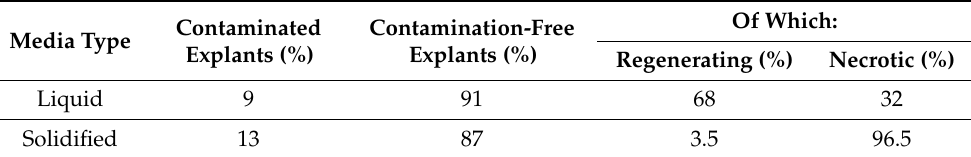
Table 1. Contamination and regeneration rate of Aldrovanda vesiculosa shoots initiated in vitro de- pending on medium solidification.